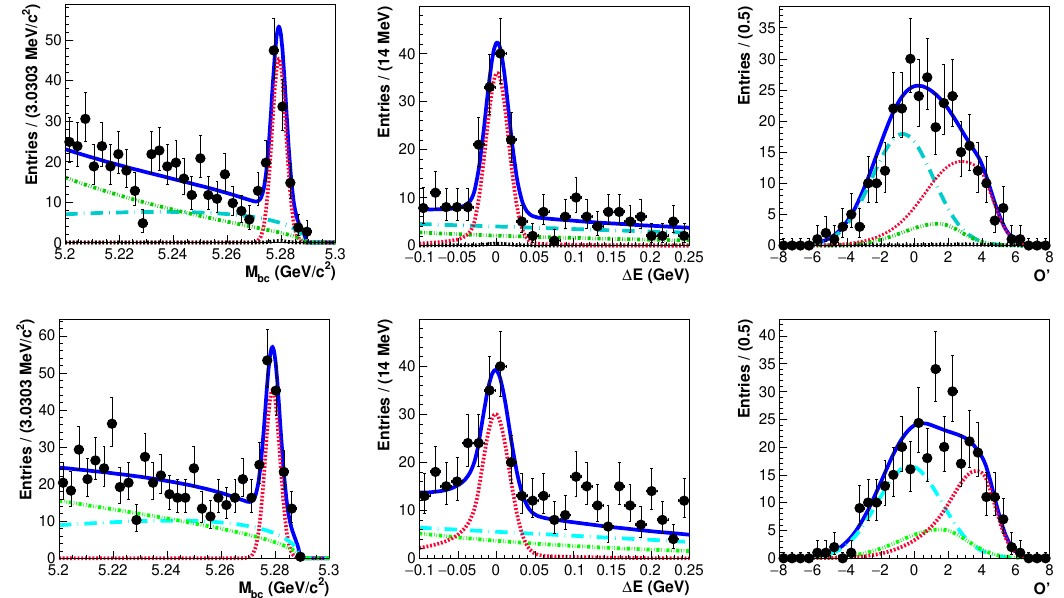
Figure 1 . Signal-enhanced M (left), ∆ E (middle), and O 0 (right) projections of three-dimensional bc unbinned extended maximum-likelihood fits to the data events that pass the selection criteria for B + → K + µ + µ − (top), and B + → K + e + e − (bottom). Points with error bars are the data; blue solid curves are the fitted results for the signal-plus-background hypothesis; red dashed curves denote the signal component; cyan long dashed, green dash-dotted, and black dashed curves represent continuum, B ¯ B background, and B → charmless decays,